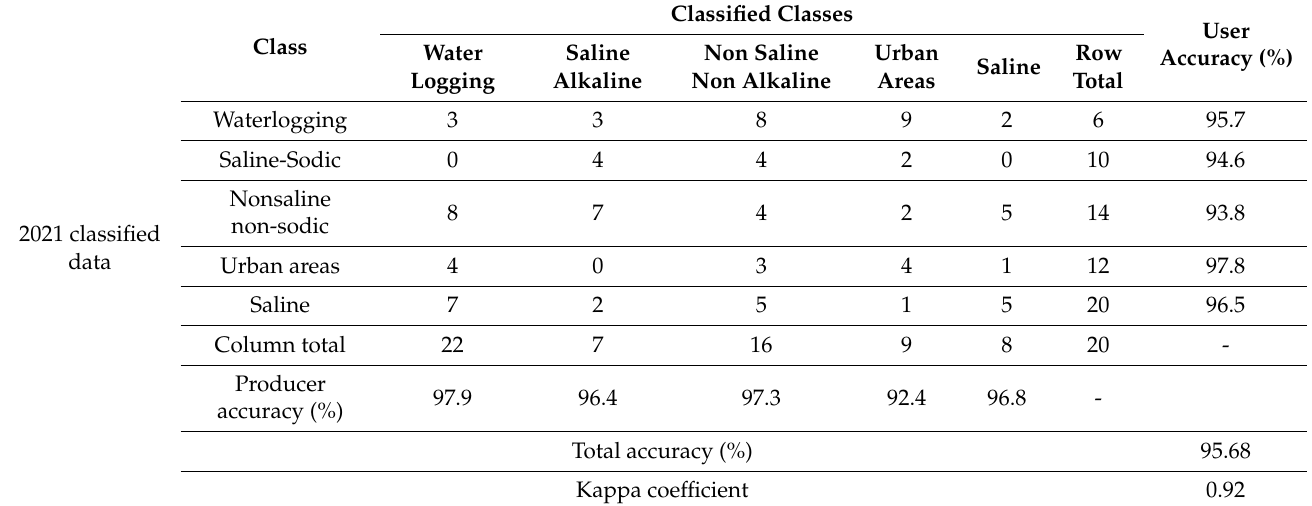
Table 7. Accuracy assessment using error matrix in 2021 based on soil survey of 20 soil profiles.